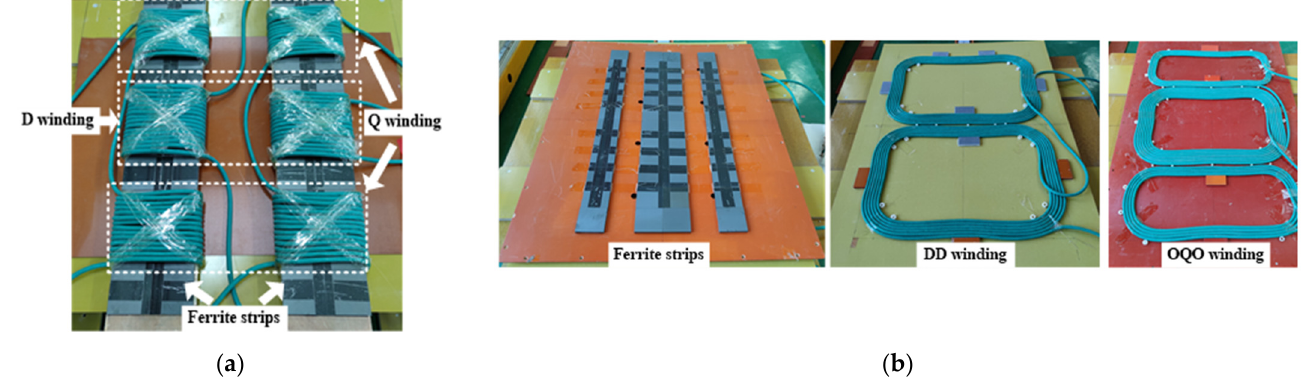
Figure 11. Details of two receivers: ( a ) Dual-phase NSP receiver; ( b ) Dual-phase DD-OQO receiver. Table 3. Measured parameters of the magnetic